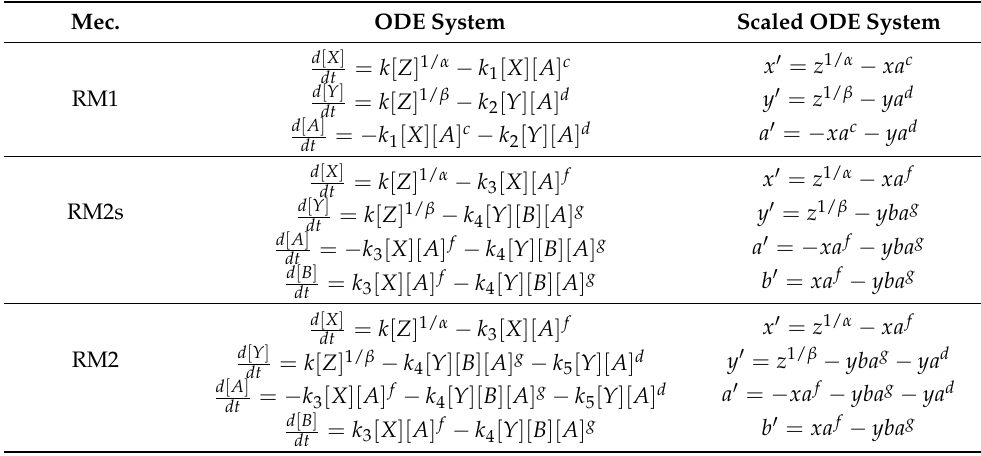
Table 3. The nonlinear first-order ODE systems derived from the chemical mechanisms and the scaled versions of the same equations for the RM1, RM2, and RM2s reaction mechanisms. Mec. ODE System Scaled ODE